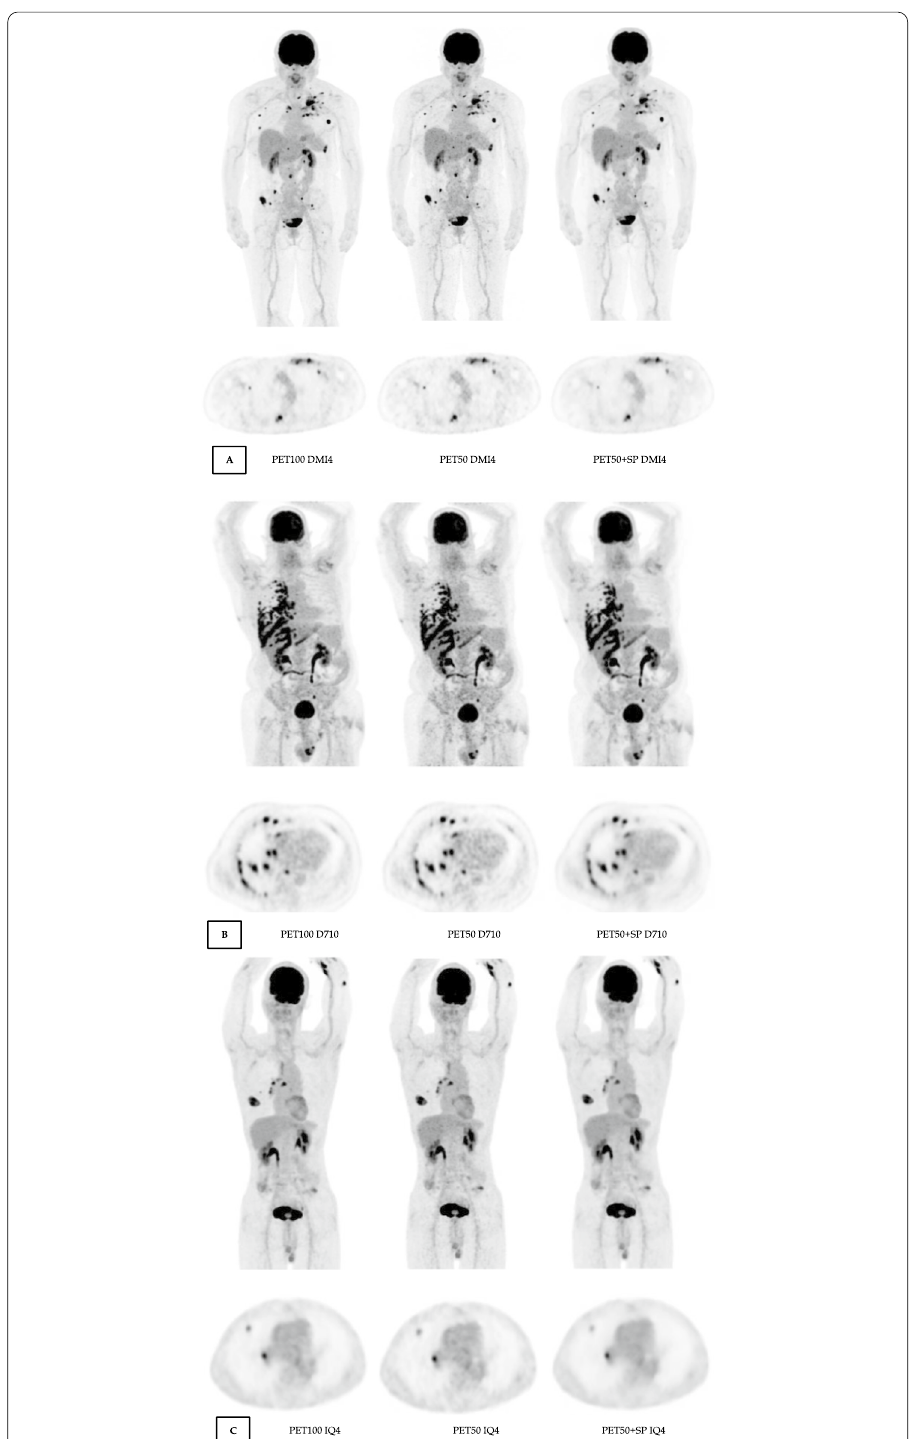
Fig. 6 Examples of MIP and axial attenuation corrected PET images reconstructed with PET100, PET50 and PET50 SP obtained on the DMI4 ( A ), D710 ( B ) and IQ4 ( C ) PET systems. Patients characteristics A Female; + 60 kg; IBM 26.7; Breast cancer B Male; 98 kg; IBM 32.4; Lung cancer; C Female; 47 kg; IBM 18.4; Lung